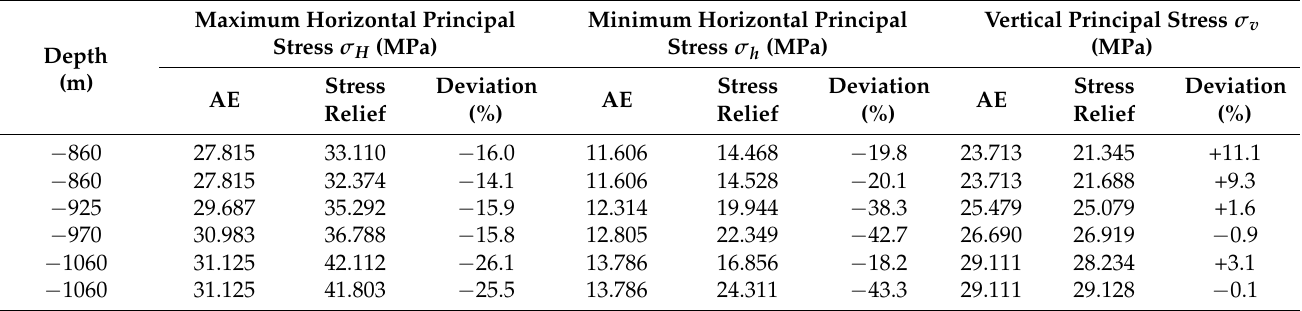
Table 3. Data comparison between the two